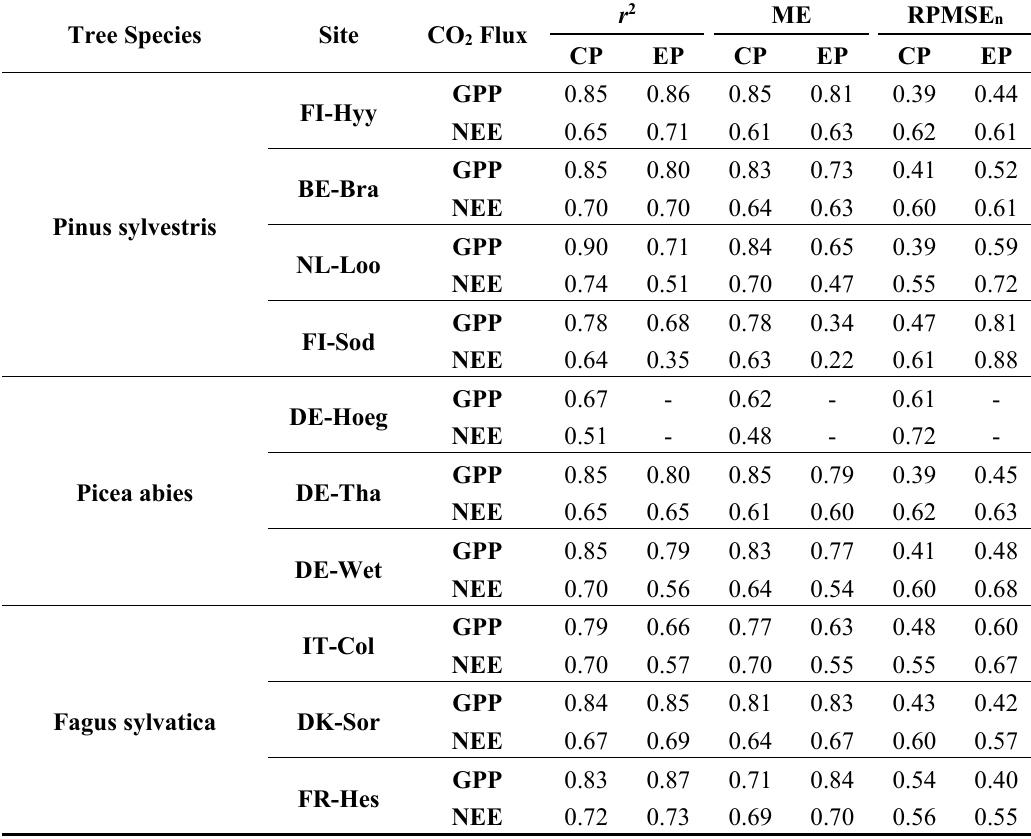
Table 5. Comparison of model evaluation criteria for daily CO 2 exchange fluxes with site-specific parameters during the calibration period (CP) and evaluation period